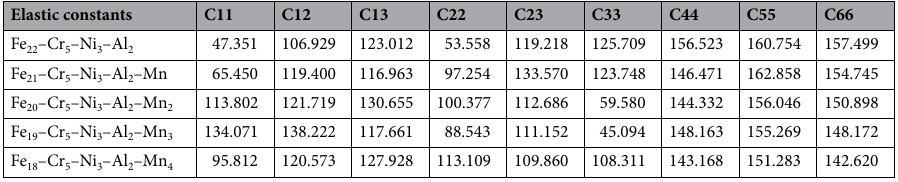
Table 3. Elastic constants of the five structural systems.